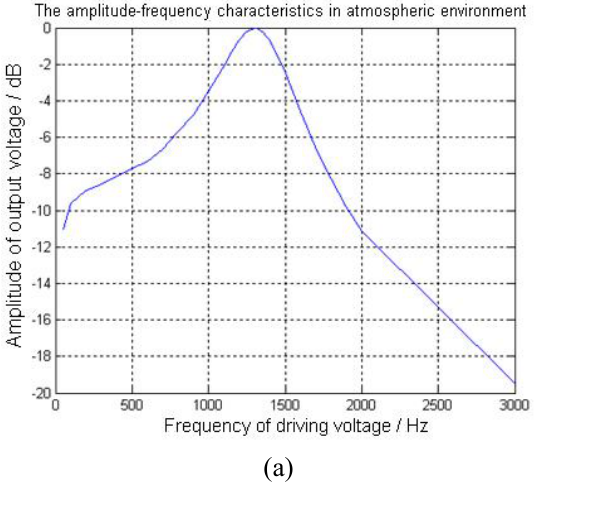
Figure 16. The amplitude-frequency characteristics in atmospheric and 10 Pa vacuum environment.